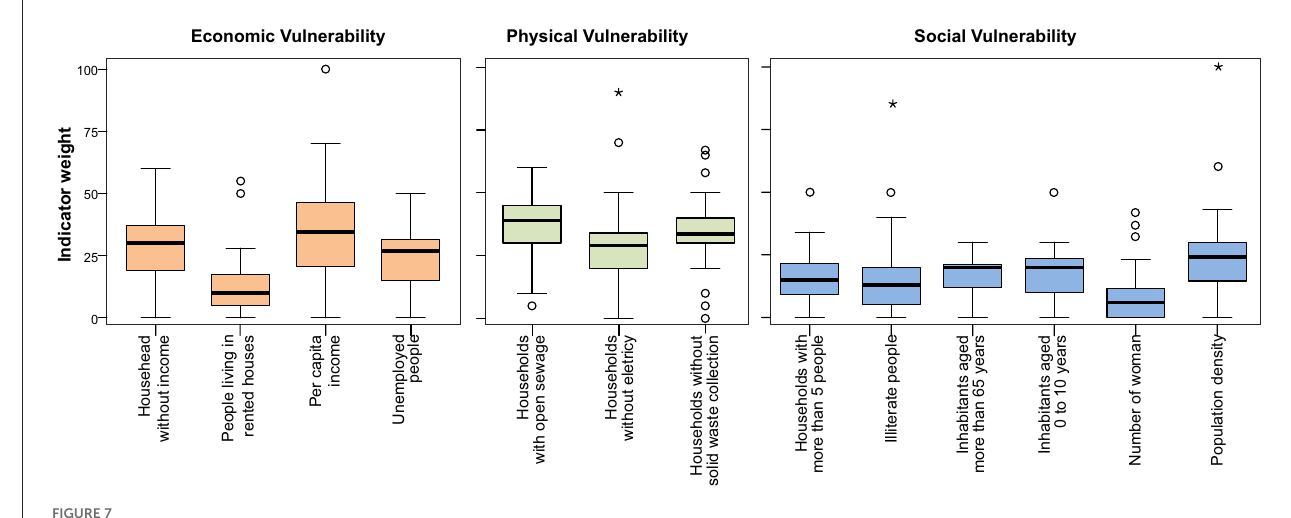
FIGURE7 Box plots showing how the indicator’s local weights varied according to the 44 survey participants.